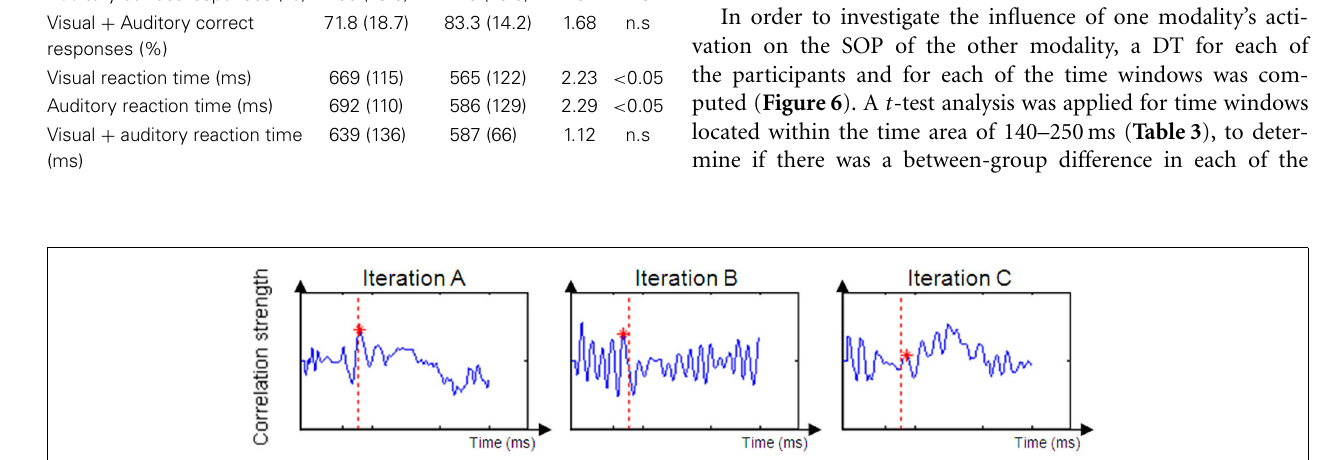
FIGURE 4 | Examples of a successful correlation result (Iteration A) and unsuccessful correlation result (Iterations B and C). Iteration (A) produced a positive peak near the original time of the unimodal